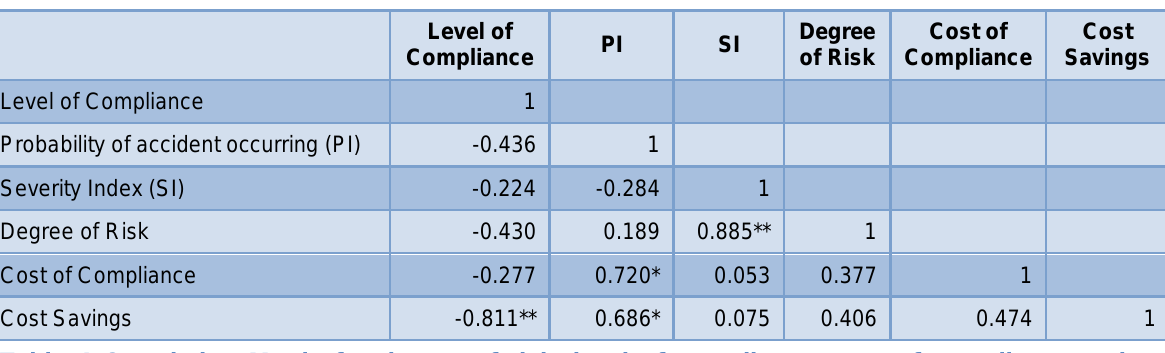
Table 4 Correlation Matrix for degree of risk, level of compliance, cost of compliance and